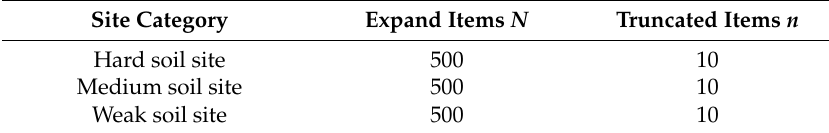
Table 3. Values of the parameters of ground motion expansion.